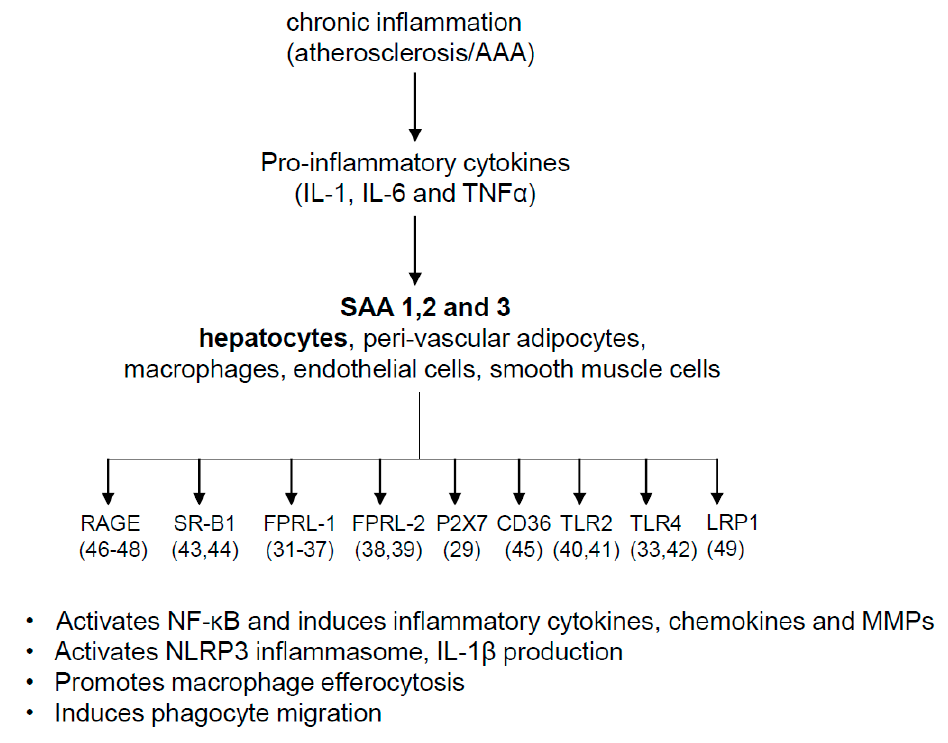
Figure 2. Proposed pathway for the production and activities of acute-phase SAAs in atherosclerosis and AAA. The numbers below the receptor names in parentheses indicate references.